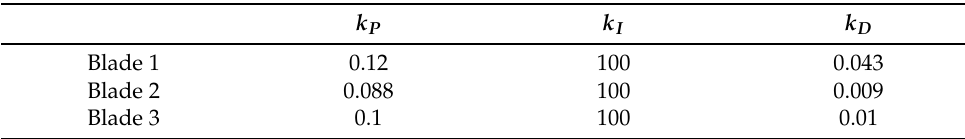
Table 1. PID gains for each